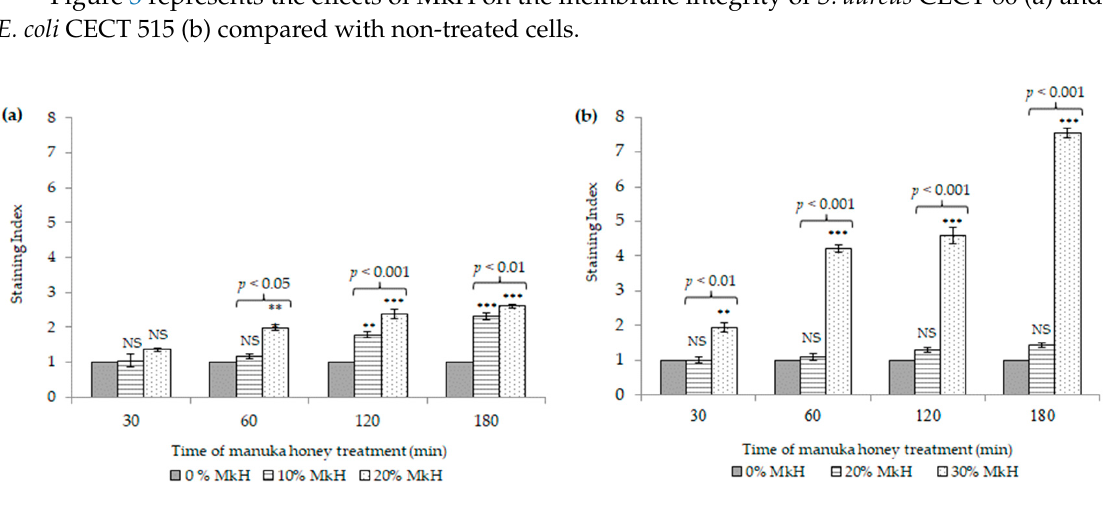
Figure 3. Effect of MkH over membrane integrity of S. aureus CECT 86 ( a ) and E. coli CECT 515 ( b ), evaluated using propidium iodide staining. Data at each time point corresponds to mean ± standard deviation. NS indicate no significant differences and asterisks indicate significant differences (*: p < 0.05; **: p < 0.01; ***: p < 0.001) between treated cells vs. the control (non-treated cells). p- values, indicate